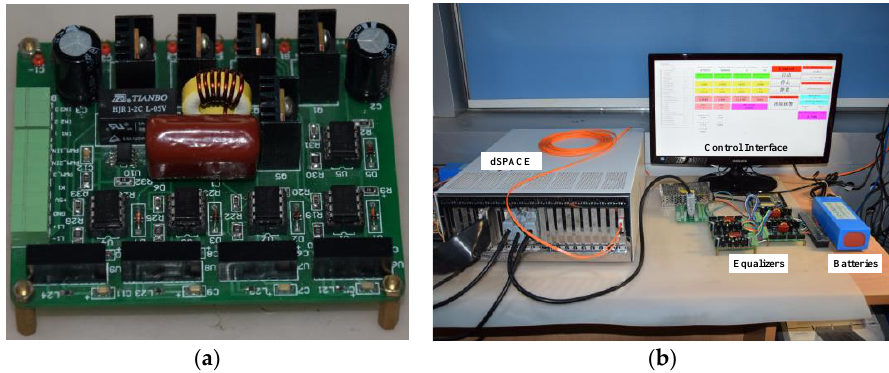
Figure 14. Photographs of the implemented engineering prototype for four lithium-ion battery cells. ( a ) balancing circuit; ( b ) experimental platform.